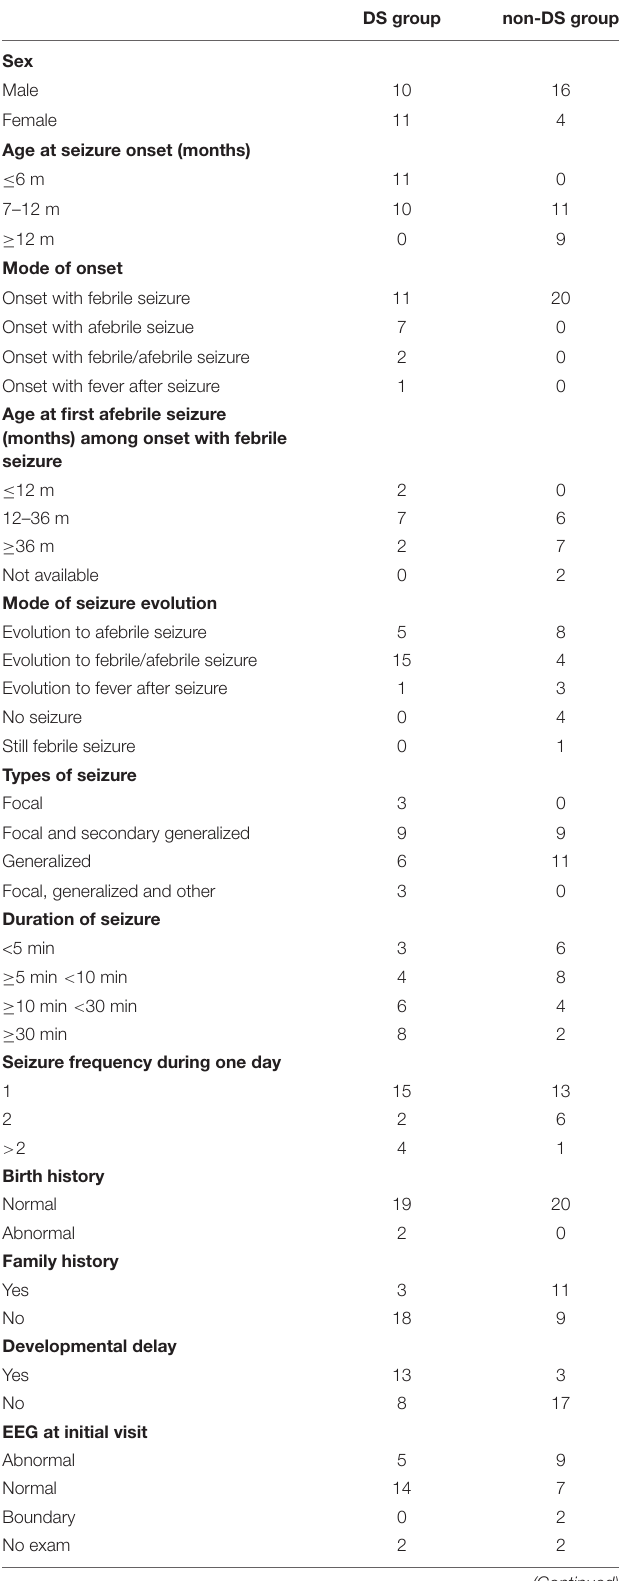
TABLE 2 | Summary of 41 patients’ clinical